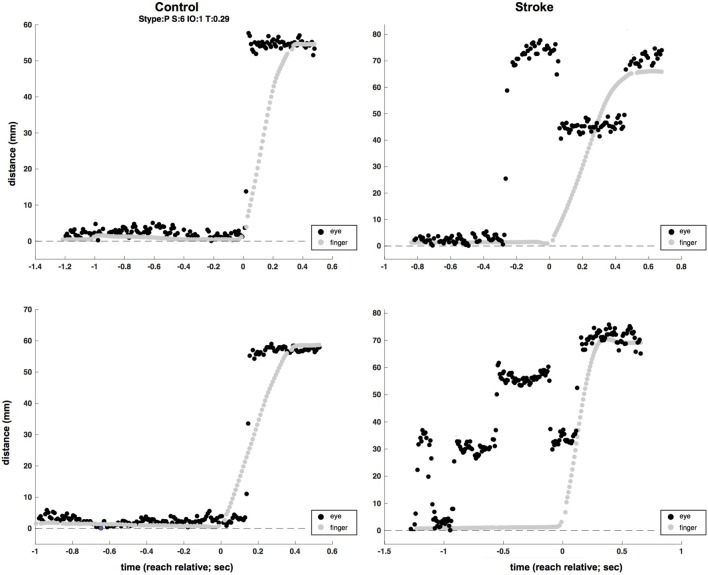
Two-sample (raw, unfiltered) eye (black) and hand (gray) traces from control (left column) and stroke (right column) participants (plotted in screen mm to allow for simultaneous plotting of eye and hand traces). Multiple eye movements are evident in the time before reach completion in the two stroke trials, as opposed to single saccades at or near the time of the reach in control trials.